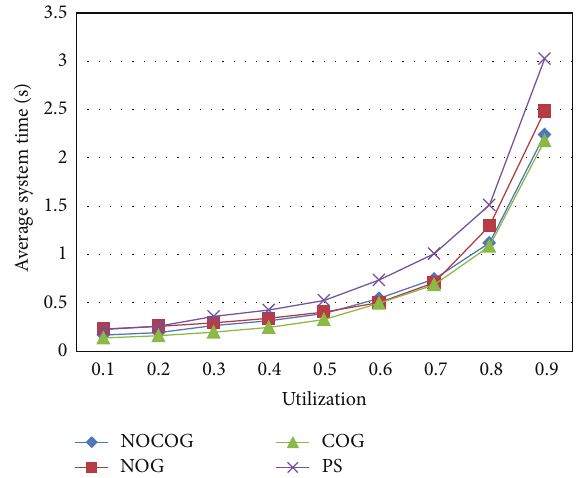
Figure 5: Average system time versus computing center utilization.